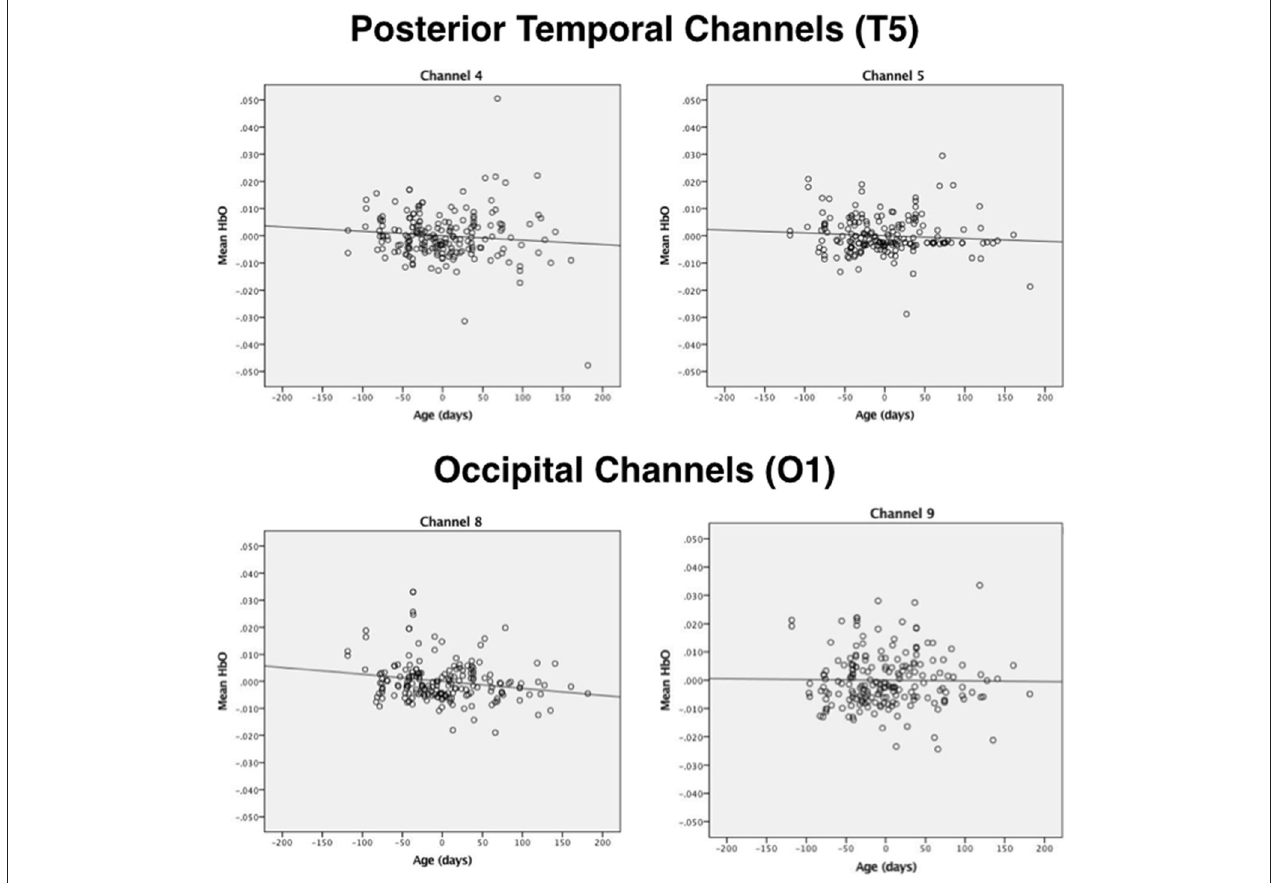
FIGURE 4 | Plots of the partial correlations for channels 4 and 5 (posterior temporal cortex) and channels 8 and 9 (occipital cortex) reported in Table 2. The partial correlations obtained at channel 4 and channel 8 were significant after controlling for false discovery